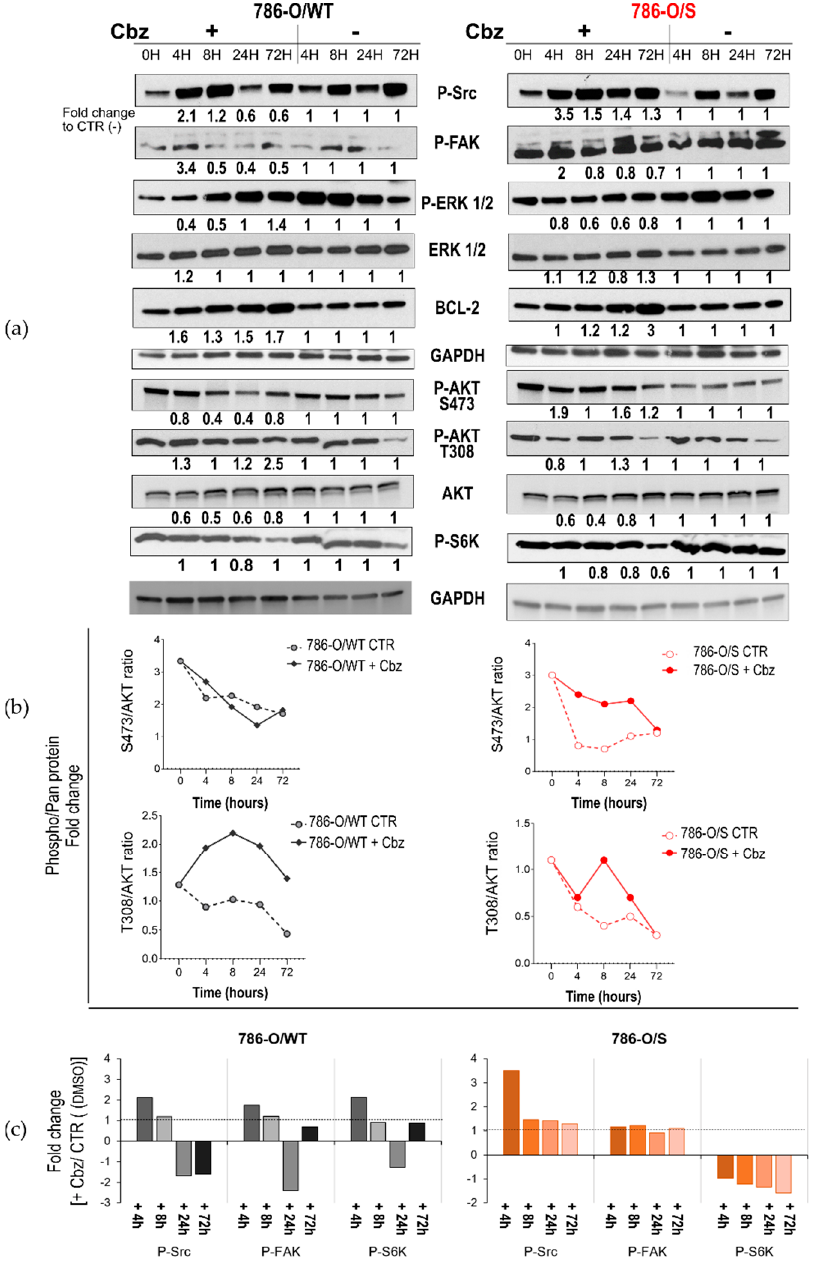
Figure 3. Effect of cabozantinib on signal transduction in human RCC treatment-naïve 786-O/WT cells and following long-term treatment with sunitinib in human RCC 786-O/S cell lines. ( a ) Cell lysates (20 µg) obtained from wild-type 786-O/WT and 786-O/S cells treated (+) with 12 µM of cabozantinib (Cbz) or untreated ( − ) with DMSO 0.1% at four time points were analyzed with an immunoblotting assay with specific antibodies for indicated proteins. GAPDH expression was chosen as the loading control for the samples. The optical density (OD) of the area of each band was quantified with ImageJ 1.52a software and normalized to that of GAPDH. Numbers below each line represent the fold changes of the target proteins, which were obtained by dividing the normalized expression from each lane by the normalized expression of the relative untreated controls (set as 1). ( b ) Kinetics of AKT (S473 and T308) in 786-O/WT and 786-O/S cells following treatment with cabozantinib (+Cbz) and untreated control (CTR) at indicated time points. The optical density (OD) of the area of each band of phosphorylated and total AKT was quanti fi ed with ImageJ 1.52a software and normalized to that of GAPDH. Phosphorylation kinesis adjusted for AKT (S473/tot AKT and T308/tot AKT). ( c ) Comparative expression levels (fold change) of proteins P-Src, P-FAK and P-S6K between cabozantinib-treated and untreated samples. The relative protein expression (densitometry